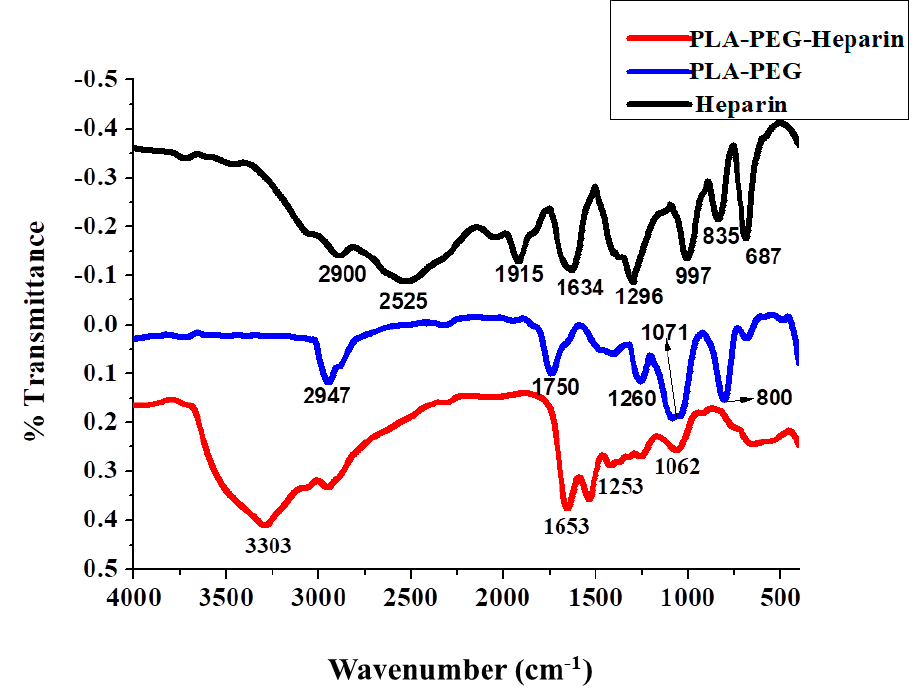
Figure 7. Overlay of the FTIR spectra of PLA-PEG, heparin, and PLA-PEG-heparin.